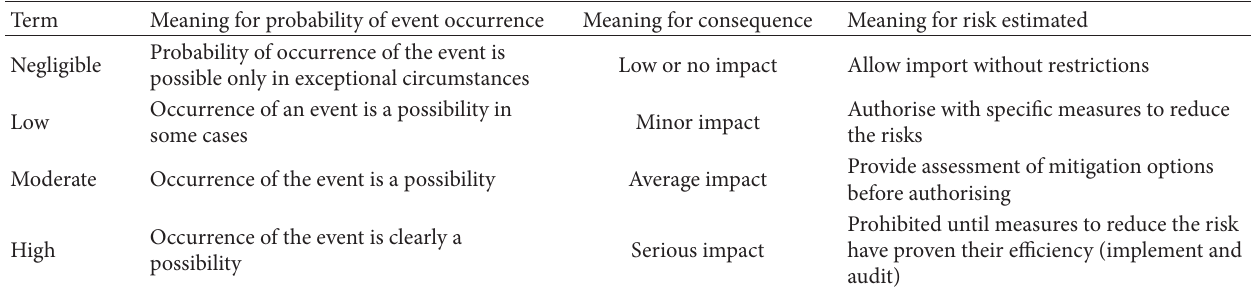
Table 1: Practical interpretation of qualitative probability ratings